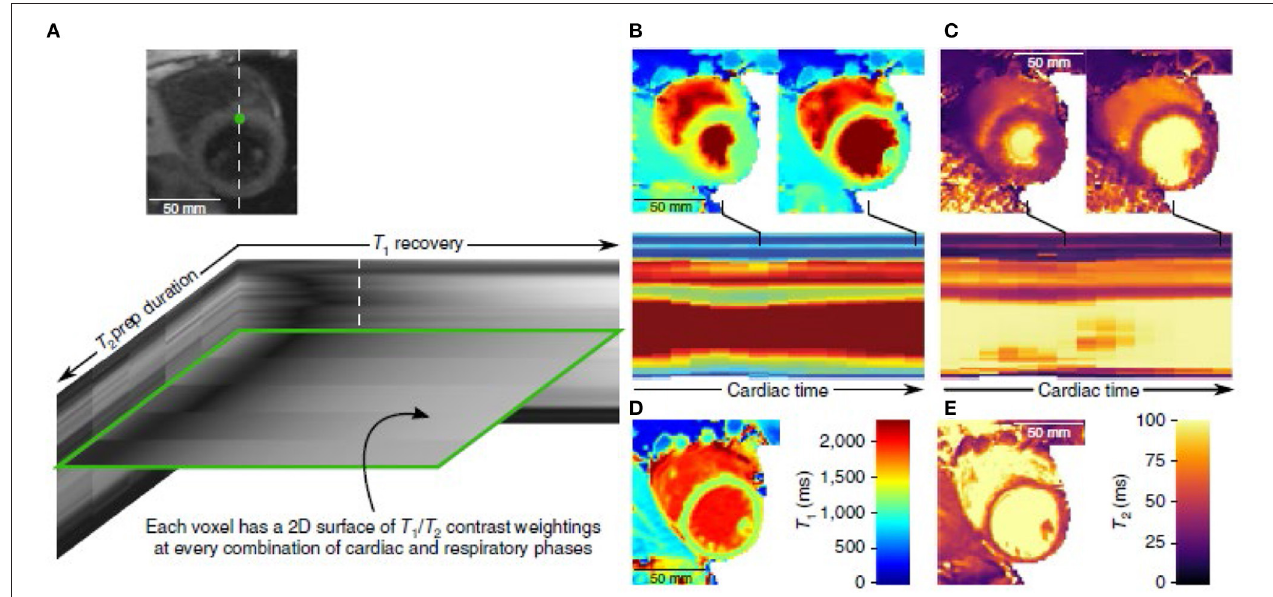
FIGURE 1 | Example of the use of multitasking imaging, with use of simultaneous T1- and T2-weighting (A) , to generate motion-resolved multidimensional images with parameter mapping (B–E) [( 4) (by